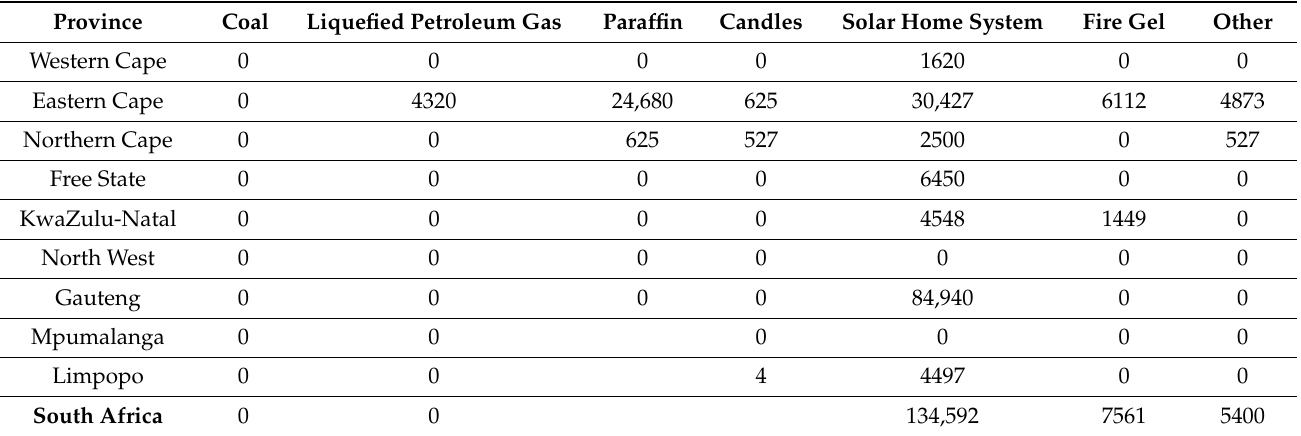
Table 6. Number of indigent households in each province provided with free basic alternative energy, 2020.